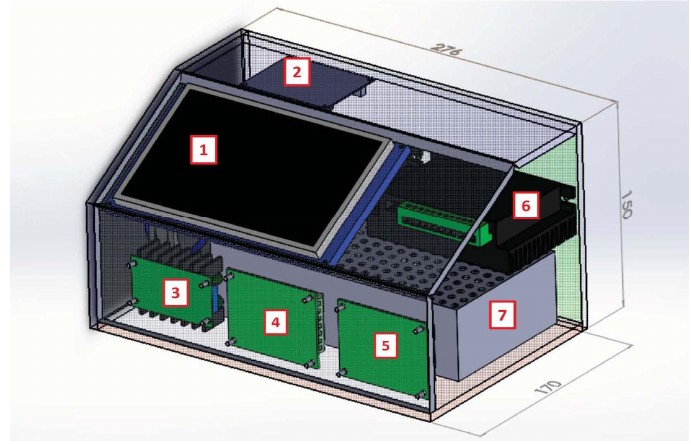
Figure 4. Assembling the electronic components in a metal case.